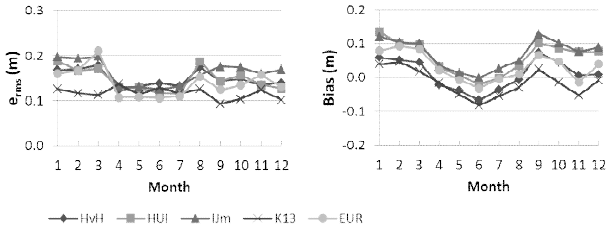
Figure 4. Monthly rms error (left) and bias (right) of surge eleva-